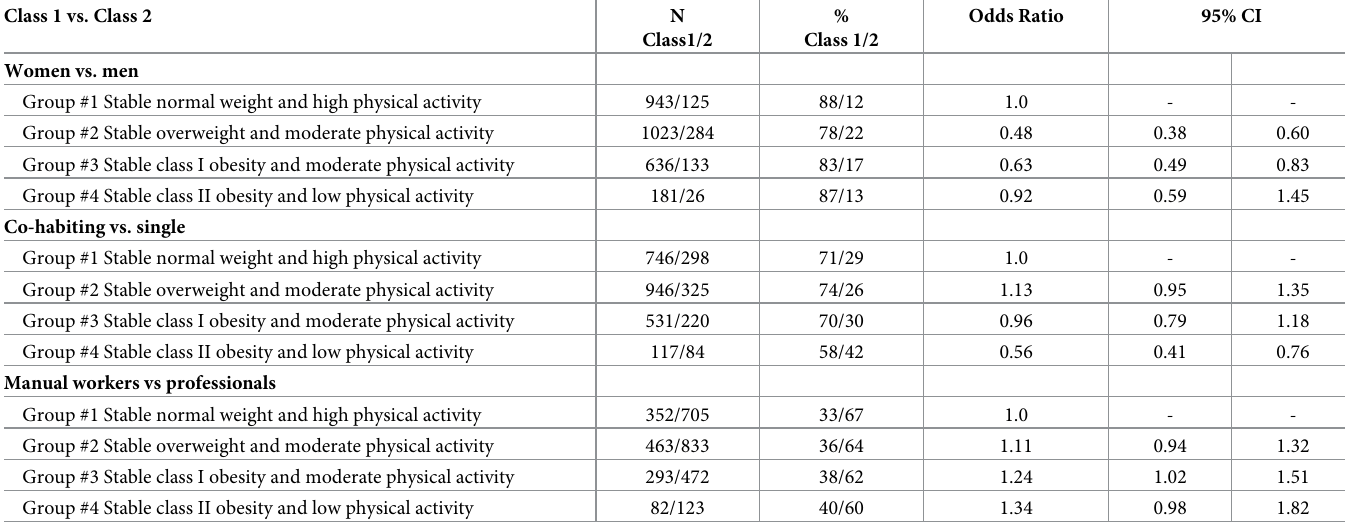
Table 3. Odds ratios of being classified to a particular group. Group #1 used as a